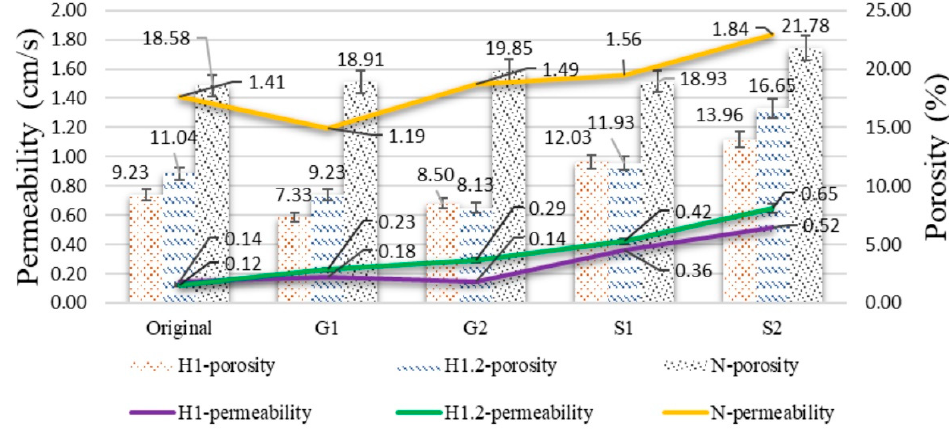
Figure 3. Porosity and permeability coefficient results for pervious concrete specimens.